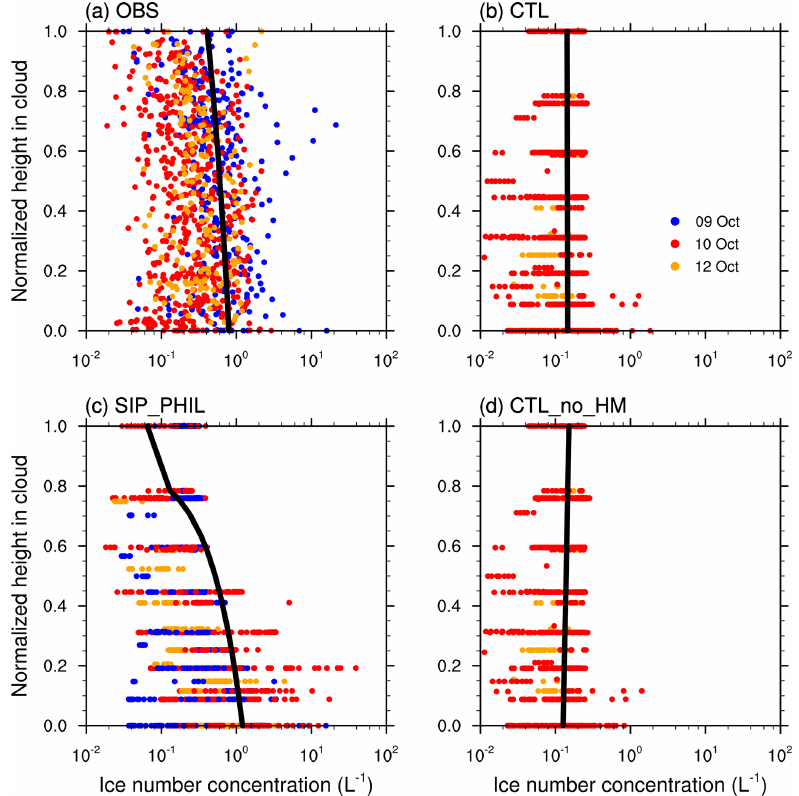
Figure 10. Ice number concentrations as a function of normalized cloud height from cloud base from (a) observations, (b) CTL, (c) SIP_ PHIL, and (d) CTL_no_HM. Solid black lines show the linear regression between ice number concentration and height. Only ice particles with diameters larger than 100µm from observations and model simulations are included in the comparison. A correction factor of 1 / 4 is applied to the observed ice number concentrations shown in (a) based on Jackson and McFarquhar (2014) and Jackson et al. (2014).